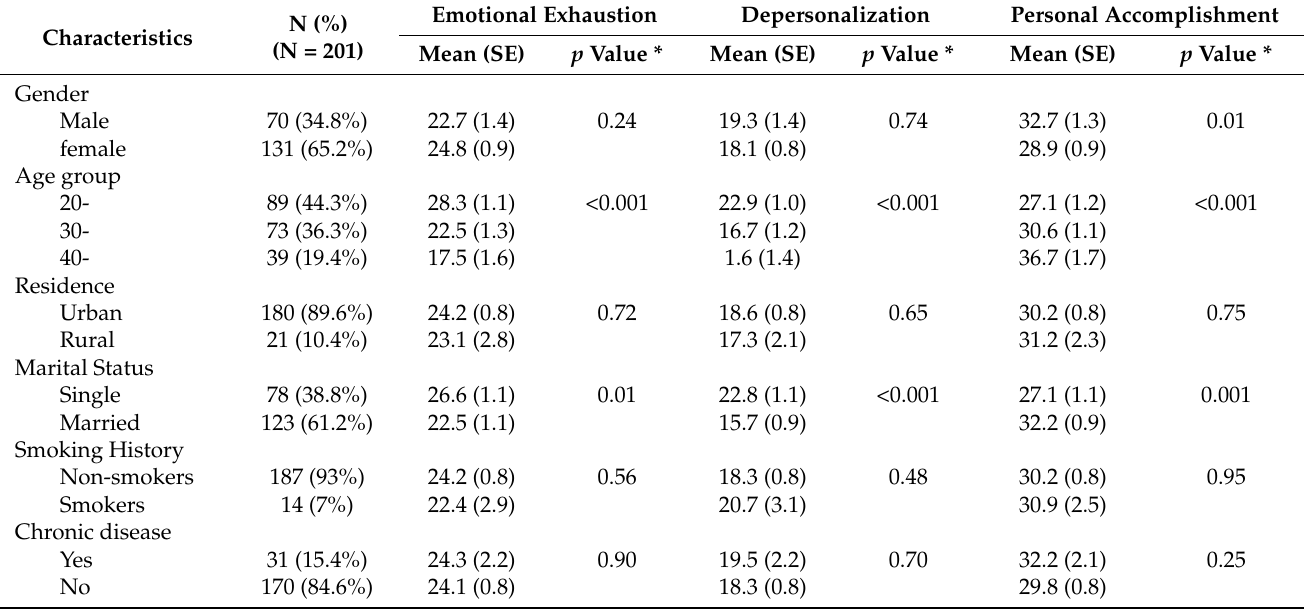
Figure 1. ( A ): Histogram graph of doctors Total MBI score, ( B ): Bar Charts of a sense of personal accomplishment (PA) Categories of enrolled doctors, ( C ) Bar Charts of emotional exhaustion (EE) Categories of enrolled doctors, ( D ) Bar Charts of depersonalization (DP) Categories of enrolled doctors. Table 2. Distribution of doctors Maslach Burnout Inventory mean scores according to sociodemographic characteristics, smoking history, and chronic